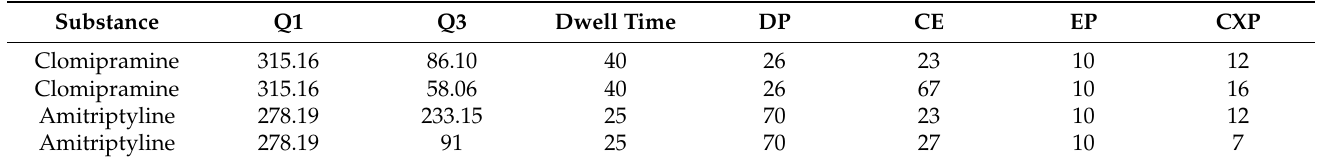
Table 3. Multiple-reaction monitoring (MRM) transitions for the studied